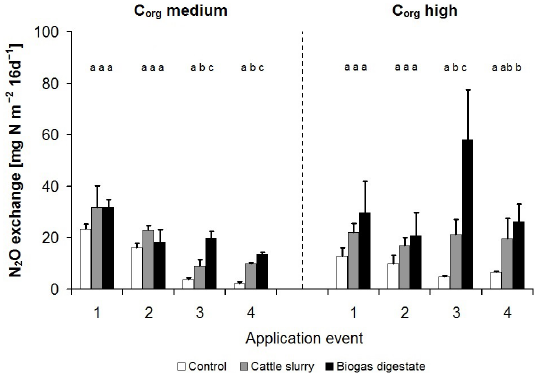
Figure 4. Cumulative N 2 O exchange during 16 days following organic fertilizer application. Bars indicate mean values + SD ( n = 3). Means with the same letter indicated no significant dif- ferences between treatments at a single application event for sites C org -medium and C org -high respectively (ANOVA, Tukey HSD test at P ≤ 0 . 05).